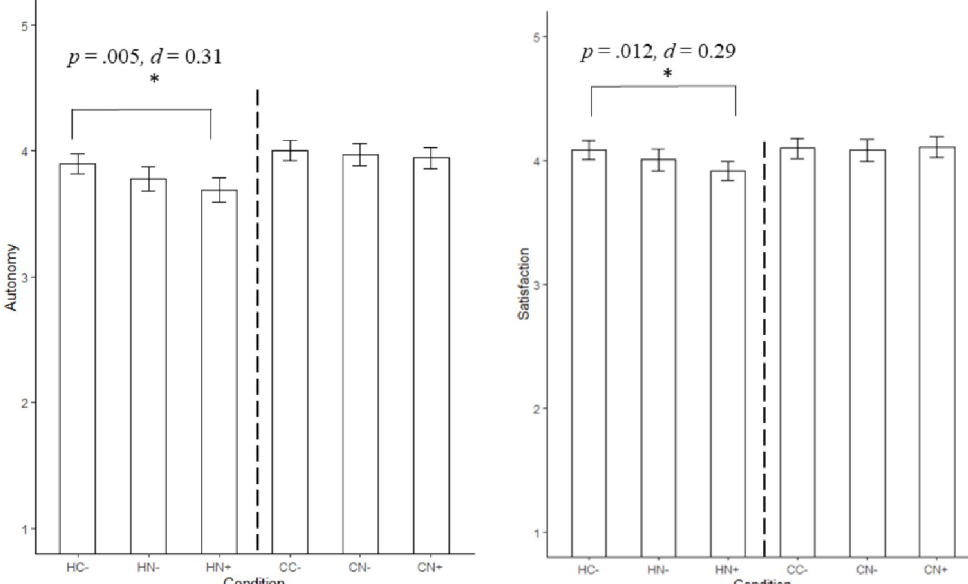
Fig 3. Means and standard errors for autonomy and